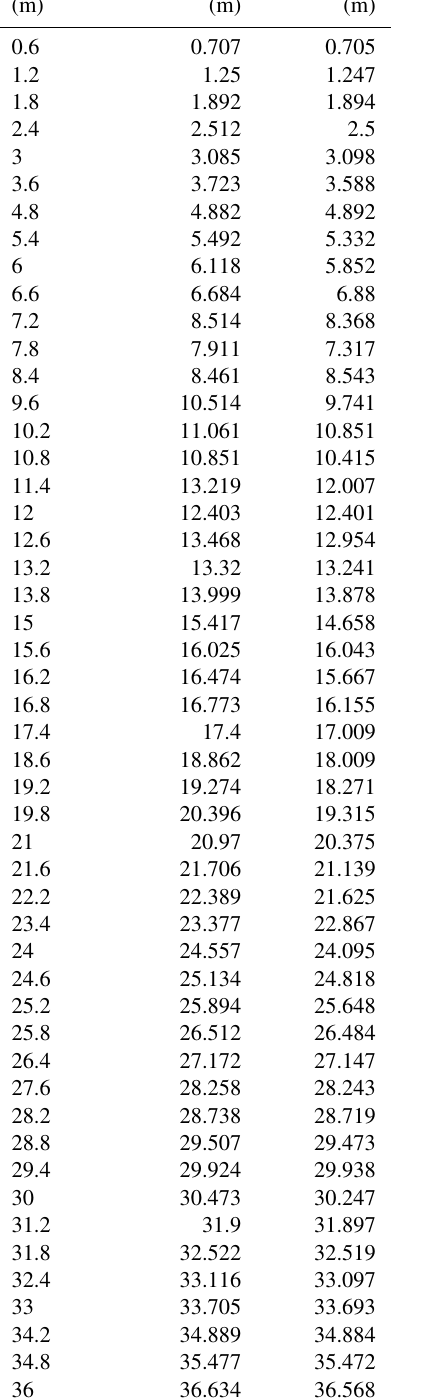
Table 2. Truth value, (measured) peak value, and (measured) mean value of the 50 training data sets.